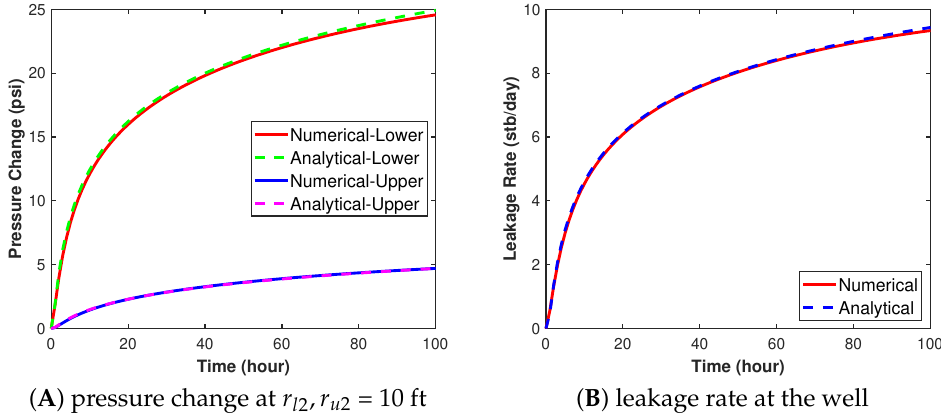
Figure 5. Comparison between the semi-analytical and the numerical solutions for the pressure change in the lower and upper layers ( A ) and the leakage rates ( B ).